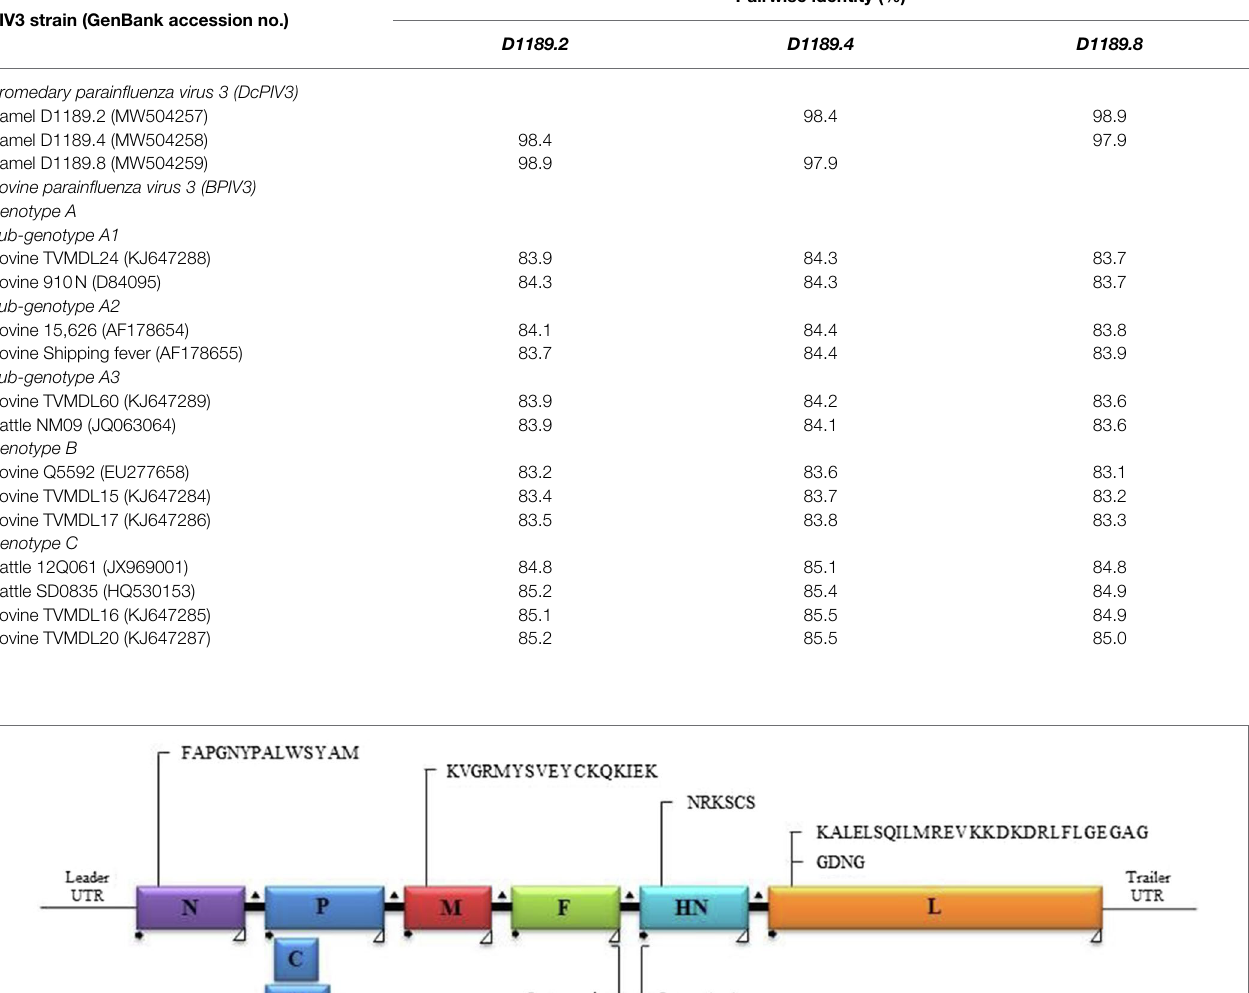
TABLE 3 | Comparison of pairwise nucleotide identity between the three DcPIV3 strains isolated from dromedary nasal samples with other representative PIV3 strains.